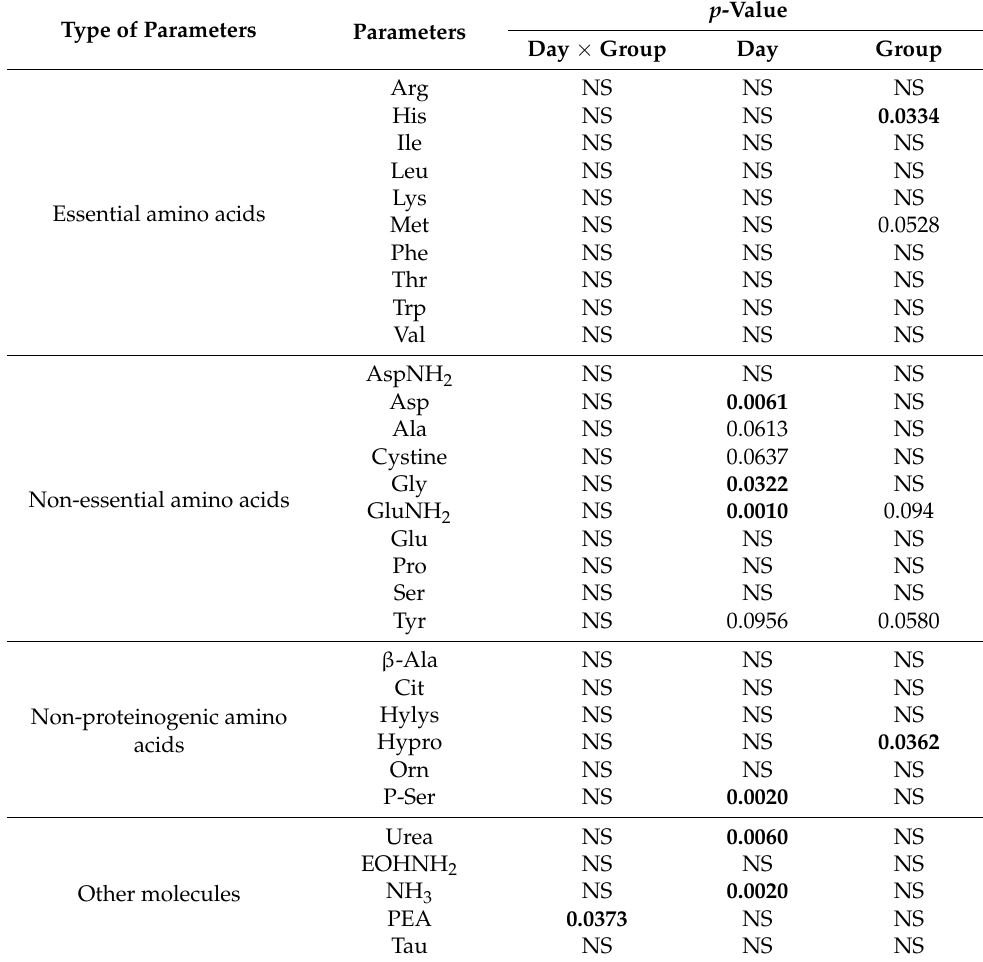
Table 2. p -values associated with the groups (growth vs. degenerate) and culture periods (day 2 vs. day 4 vs. day 6) in bovine secondary follicle culture on amino acid